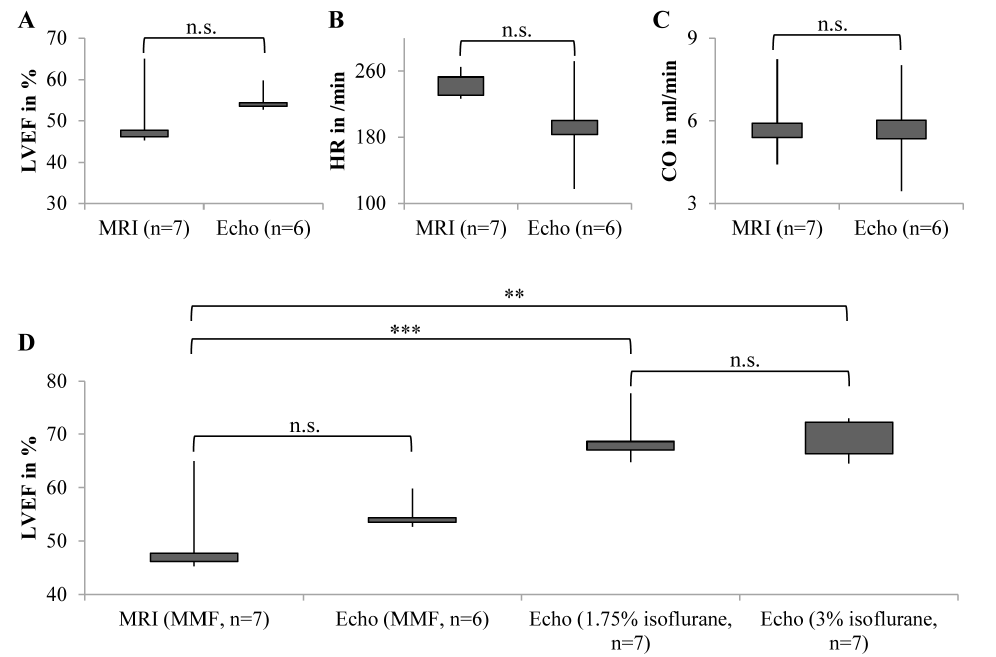
Figure 2. Echocardiography confirms values obtained by MRI. A) Echocardiography was able to reproduce the low LVEF values we obtained from MMF anesthetized mice investigated by MRI. B) Heart rates (HR) and C) cardiac output (CO) measured by our Vevo2100 system did not significantly differ from those in the MRI study. D) Anesthesia with isoflurane revealed the cardiodepressive effects of MMF. n.s.: not significant; **: p , 0.01; ***: p ,